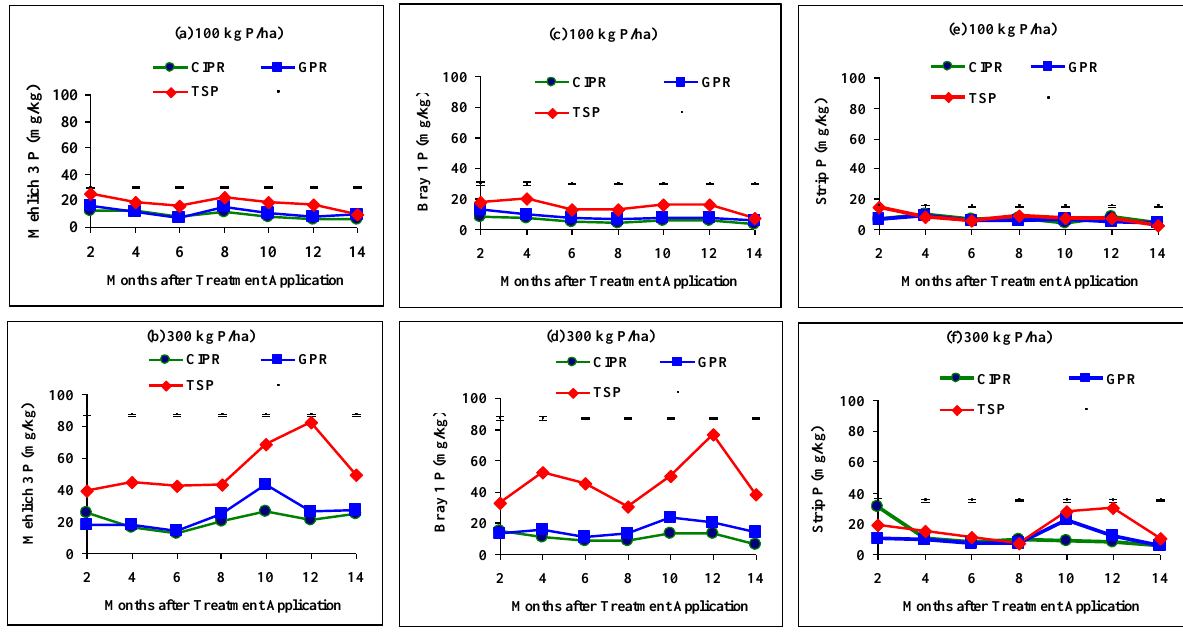
FIGURE 1 . Phosphorus extracted from the three P sources at 100 and 300 kg P ha –1 by (a,b) Meh3, (c,d) B1, and (e,f) strip. Note that the bars denote S.E. of the means and the data points for TSP at 300 kg P ha –1 , months 10 and 12 were considered outliers.